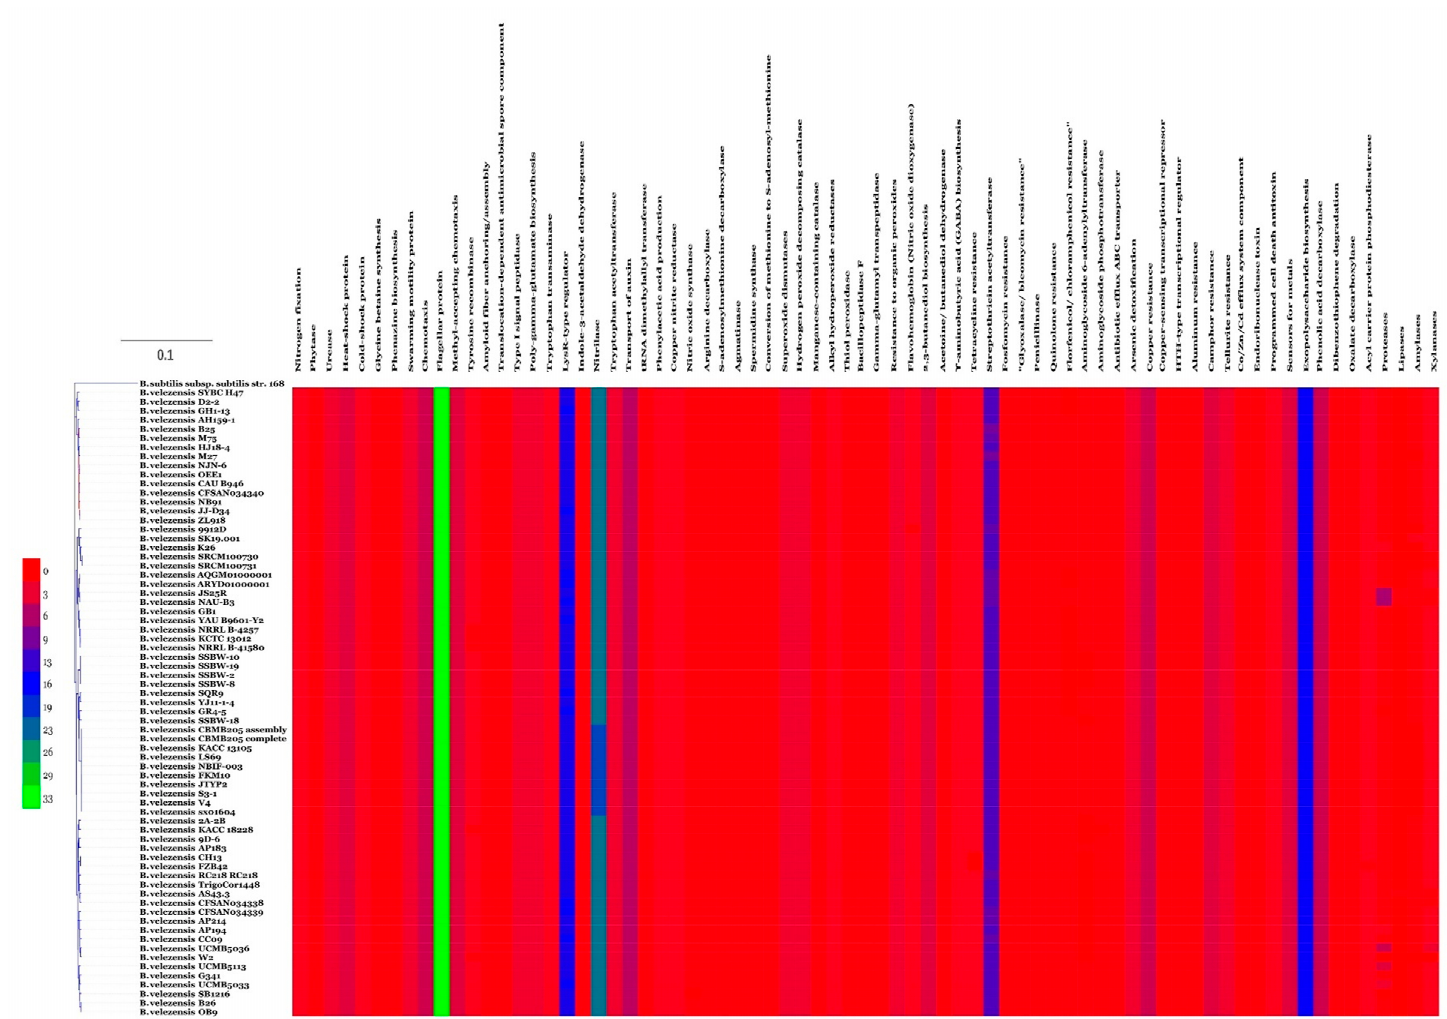
Figure 4. Heat map resulting from the genome mining of genes contributing to plant-beneficial functions in B. velezensis isolates. Gene copy number varies between 0 and 33 according to the indicated colour code. 471